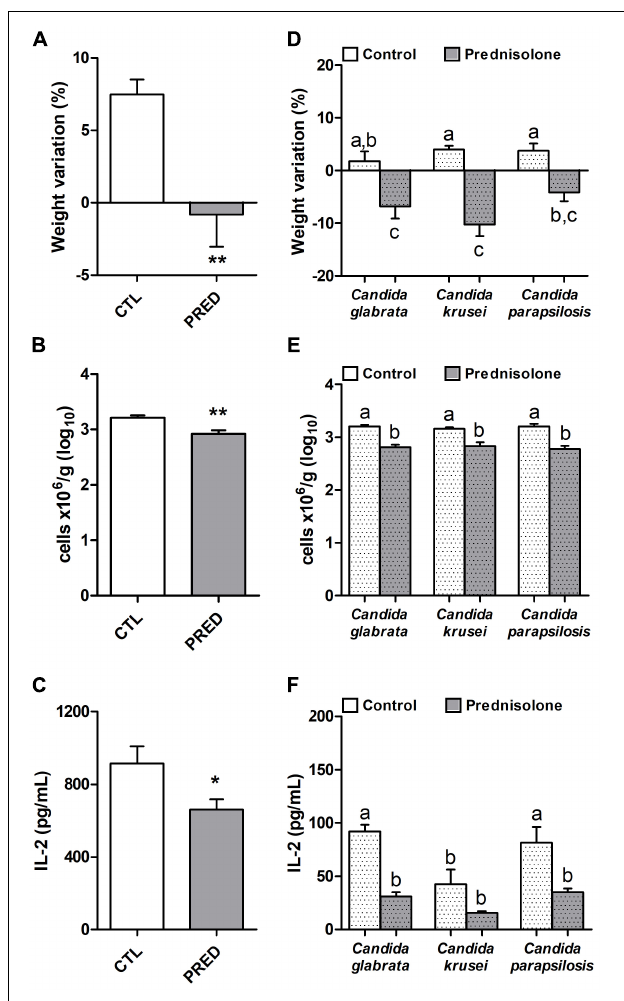
FIGURE 2 | Effect of prednisolone in non-infected and infected mice. Body weight (A,D) , total spleen leukocyte cell number (B,E) and production of IL-2 by spleen cell cultures (C,F) in immunocompetent (CTL – control) and immunosuppressed (PRED – Prednisolone) non-infected and infected mice. The results are expressed as mean ± SEM; ∗ p < 0.05 and ∗∗ p < 0.01 statistical difference between groups analyzed by t -test; different letters indicate statistical difference among groups analyzed by One-way ANOVA with post hoc Tukey test; p < 0.05; n =